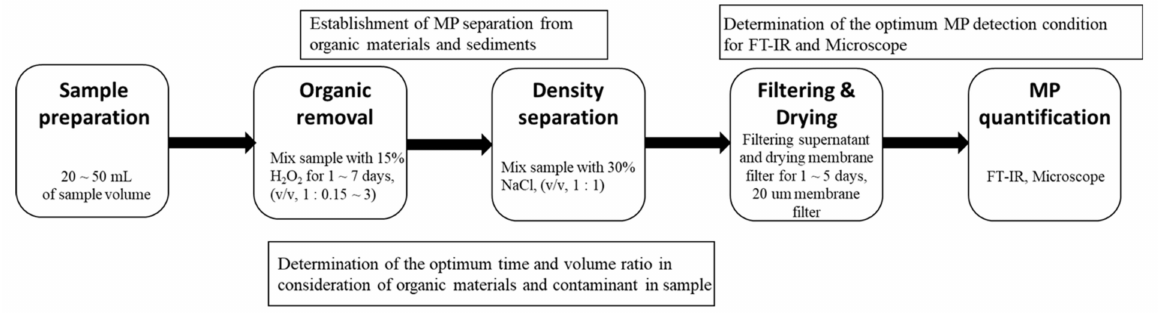
Figure 1. Procedure of microplastic (MP) analysis in